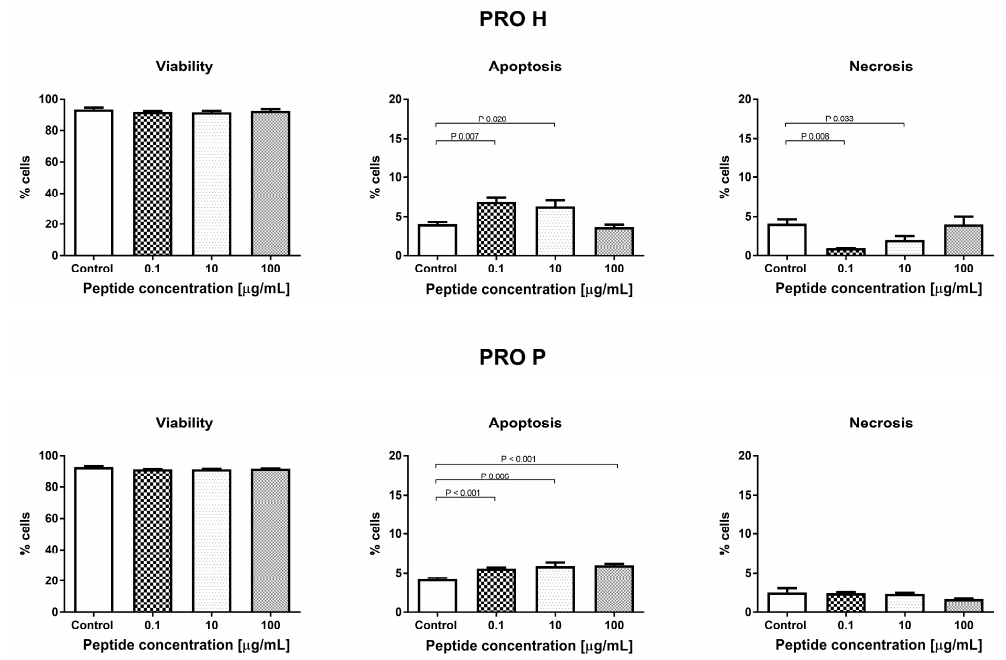
Figure 2. Evaluation of cell apoptosis, necrosis, and viability with PRO H and PRO P.